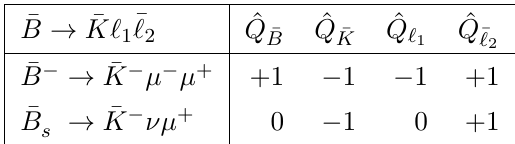
Figure 2 . O ( e ) -graphs with nomenclature referring to photon-emission and the P stands for point-like and can also be interpreted as a contact term.